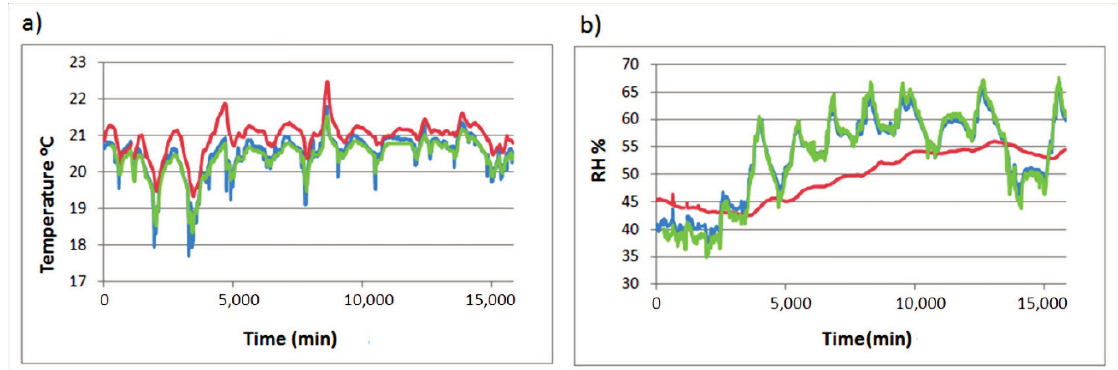
Figure 11. Trajectories of sensor inside the display cabinet (red), sensor at the outside of the display cabinet (blue) and control data-logger at the outside of the display cabinet (green). ( a ) Temperature; ( b )